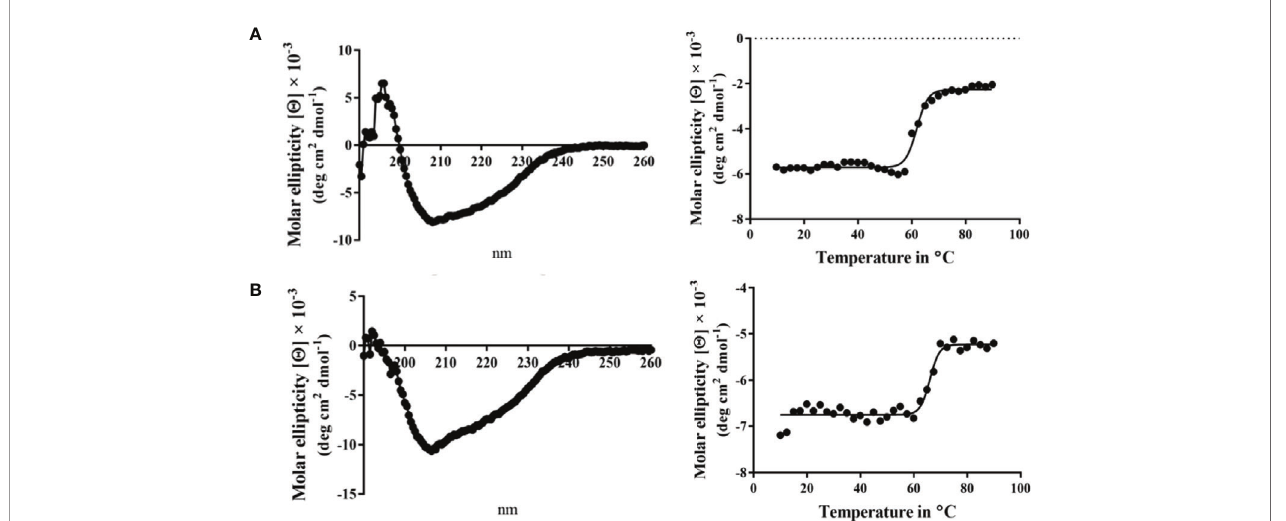
FIGURE 2 | Circular dichroism (CD) spectra and thermal unfolding for wild-type Spa33 and Spa33 C . CD spectroscopy was used to analyze the secondary structure content and thermal stabilities of wild-type Spa33 and Spa33 C . (A) The CD spectrum of wild-type Spa33 shows a negative peak at 208 nm with a modest shoulder at 222 nm (left). This spectrum is indicative of a signi fi cant amount of b -structure. To determine the Tm for wild-type Spa33, the molar ellipticity at 222 nm was monitored as a function of temperature. Based on the large transition observed (right) the Tm was found to be 61.88°C. (B) The CD spectrum of Spa33 C also shows more dominant 208 nm minimum suggesting a dominant b -structure component (left). Based on the thermal unfolding curve for Spa33 C (right) the Tm was determined to be 65.12°C.